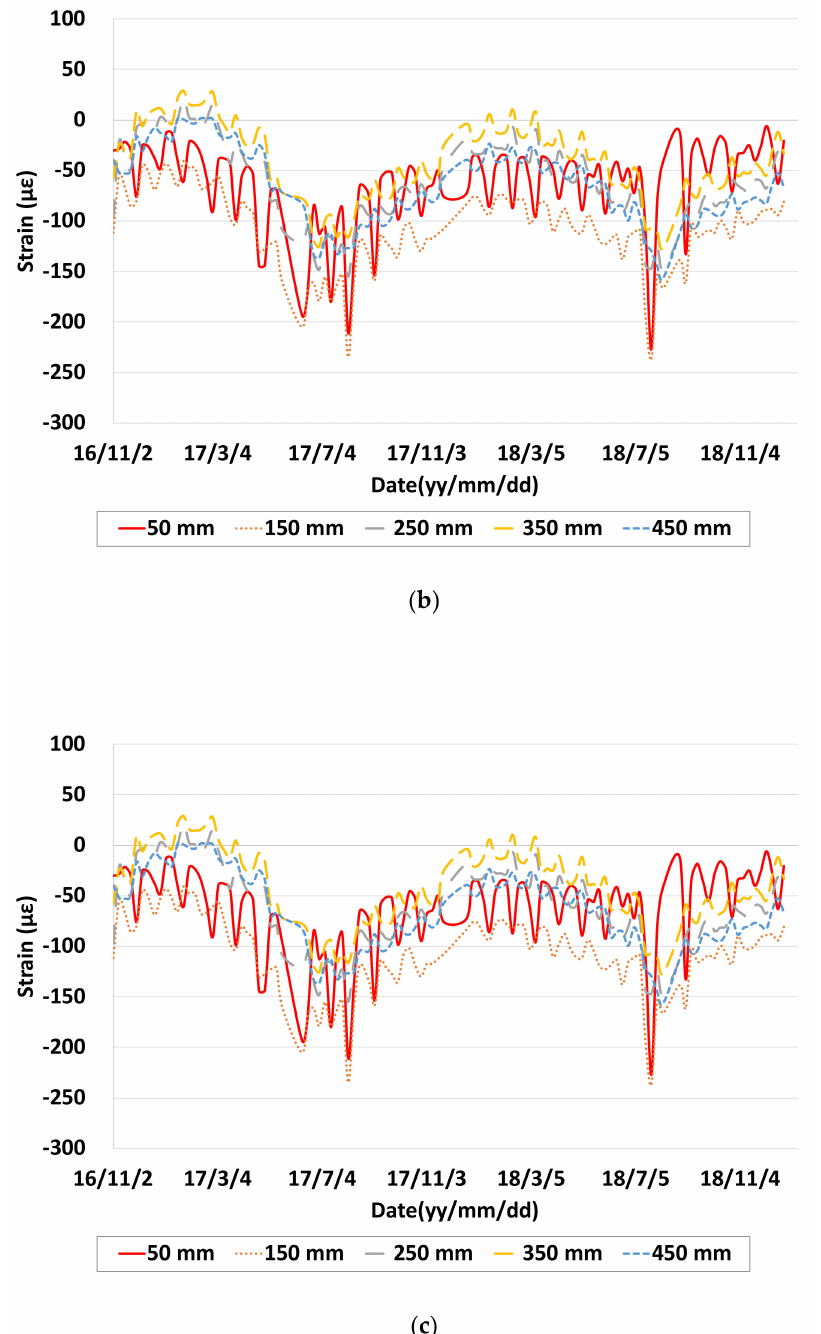
Figure 18. Shrinkage strain according to the slab depth over a two-year period: ( a ) corner, ( b ) mid-edge, and ( c )